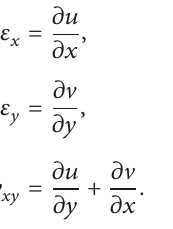
where 𝜎 𝑥 , 𝜎 𝑦 , 𝜏 𝑥𝑦 and 𝜀 𝑥 , 𝜀 𝑦 , 𝛾 𝑥𝑦 , respectively, are the stresses and strains. The elastic stiffness coefficients 𝑄 𝑖𝑗 ( 𝑖, 𝑗 = 1, 2, 6